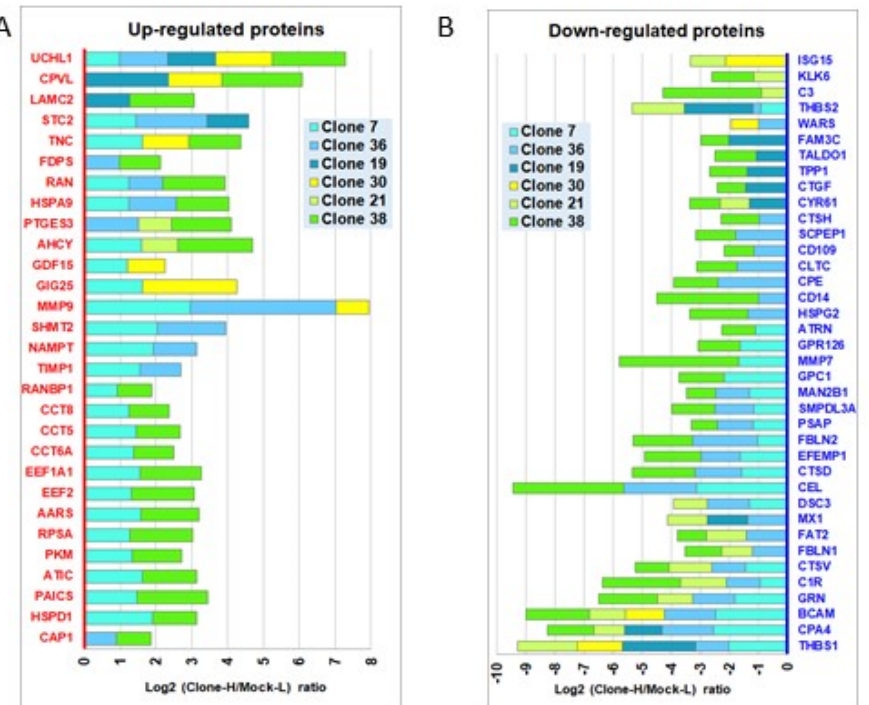
Figure 1. Distribution of multiple converging up- or down-dysregulations of secreted proteins across the 6 KRAS-clones (H), each paired with a Mock (L) sample, obtained by SILAC MS quantitative proteomics. Cutoff for dysregulation: log2 ratios (H/L) exceeding ± 0.8916. ( A ) All the 29 upregulated proteins. ( B ) All the 38 downregulated proteins.